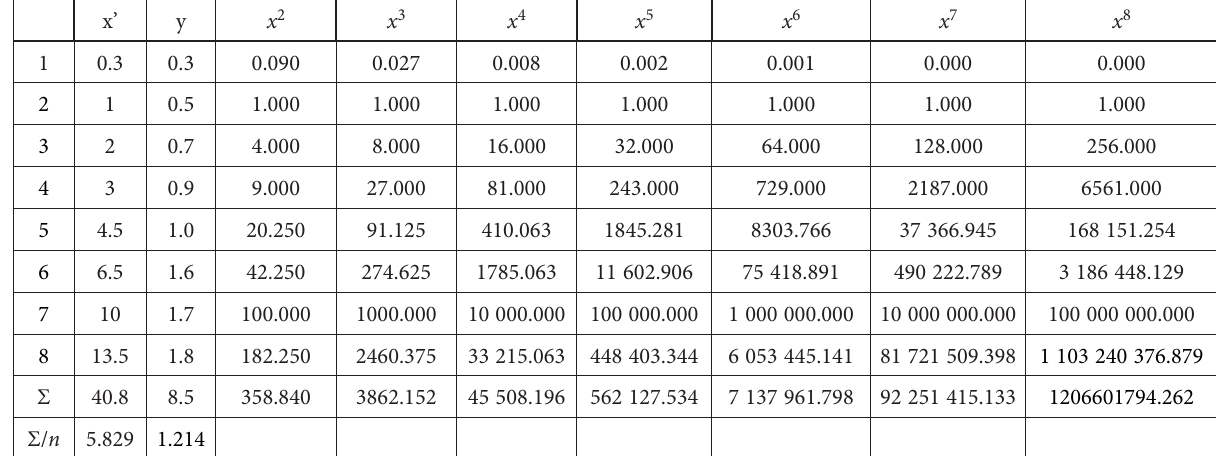
Table 5. Calculation of the normal equations